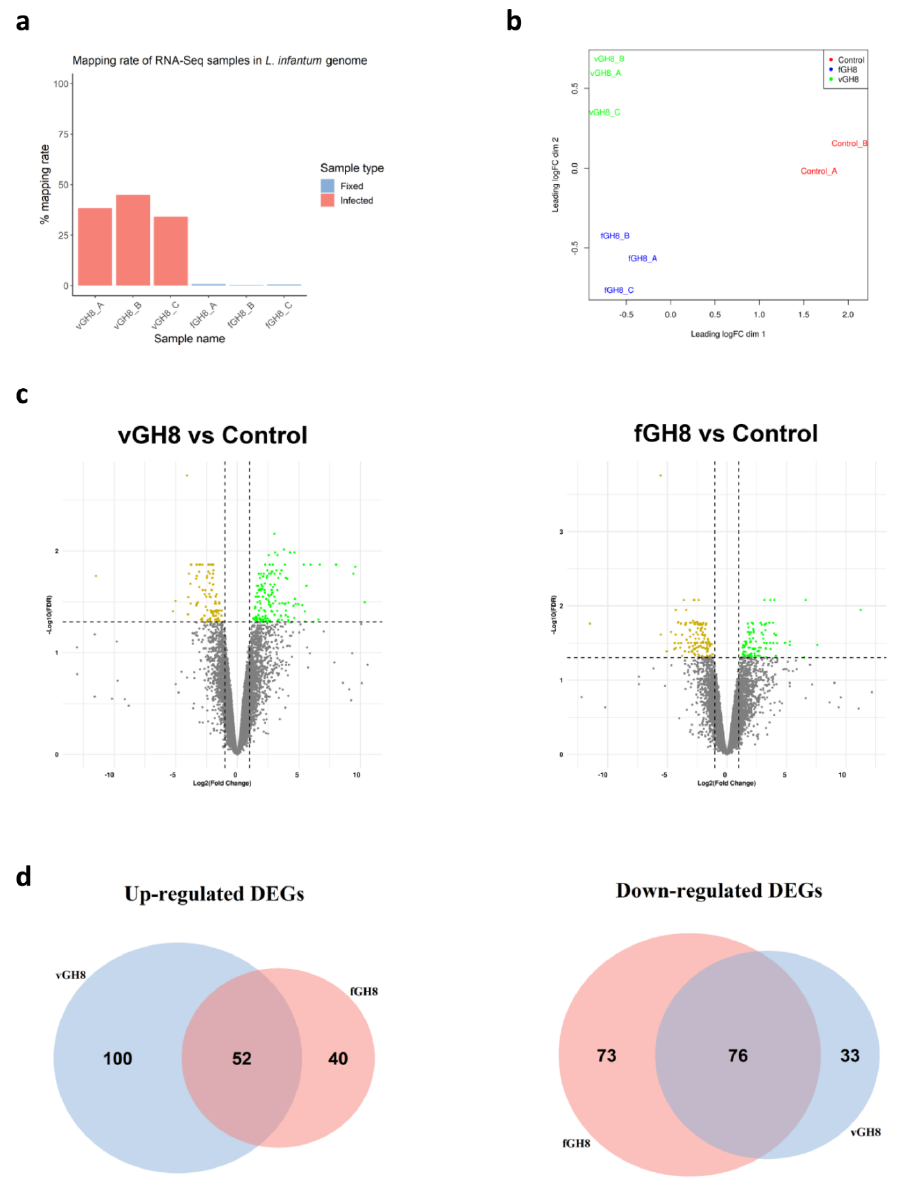
Figure 3. Identification of differentially expressed genes (DEGs) in Leishmania -infected BMDCs (vGH8) and BMDCs harboring fixed parasites (fGH8): ( a ) Mapping rates of RNA-seq samples in L. infantum genome; ( b ) Multidimensional scaling (MDS) plot of DEGs in Leishmania -infected BMDCs (vGH8), BMDCs harboring fixed parasites (fGH8) and naïve BMDCs (Control); ( c ) Volcano plots showing differential expression analysis between vGH8 versus Control and fGH8 versus Control BMDCs. Up- and downregulated genes (FDR < 0.05) are depicted with green and yellow, respectively; ( d ) Venn diagrams portraying the number of exclusively and common up- (left) and downregulated (right) genes for each comparison.